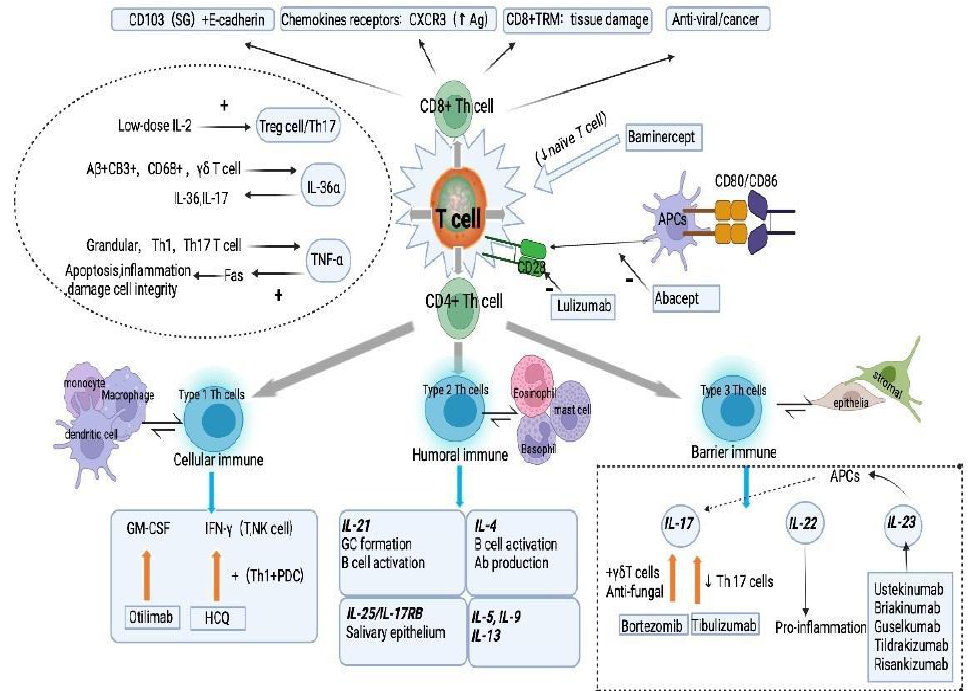
Figure 1. The effect of T cells on the pathologics of pSS.